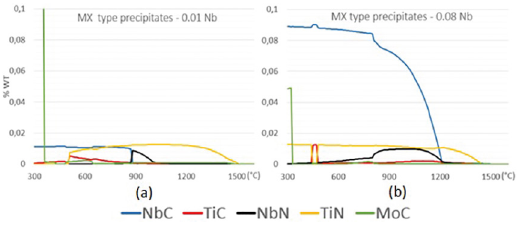
Figure 6. MX type simulation on 0.01 (a) and 0.08 (b) niobium steels. Regarding the wear resistance after quenching, steels with similar type of microstructure show a linear decrease in weight loss with decreasing grain size 28 . So, it is possible that higher amount of niobium is responsible for grain refining and the better wear performance in 0.08 Nb steel after